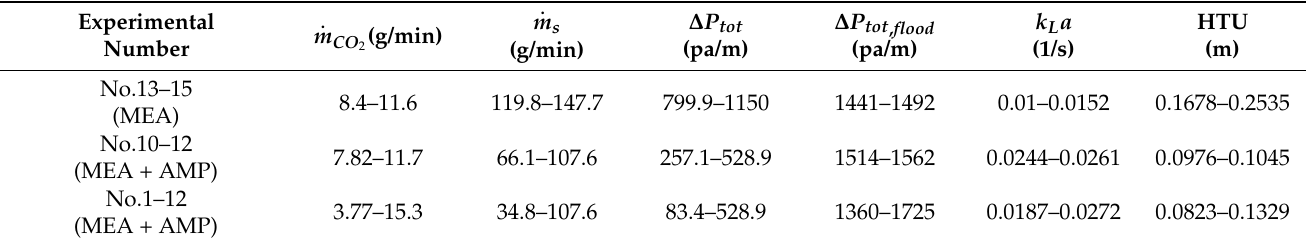
Table 2. A comparison of mixed solvent with base-line solvent in hydrodynamic and mass-transfer. HTU: Height of transfer unit.